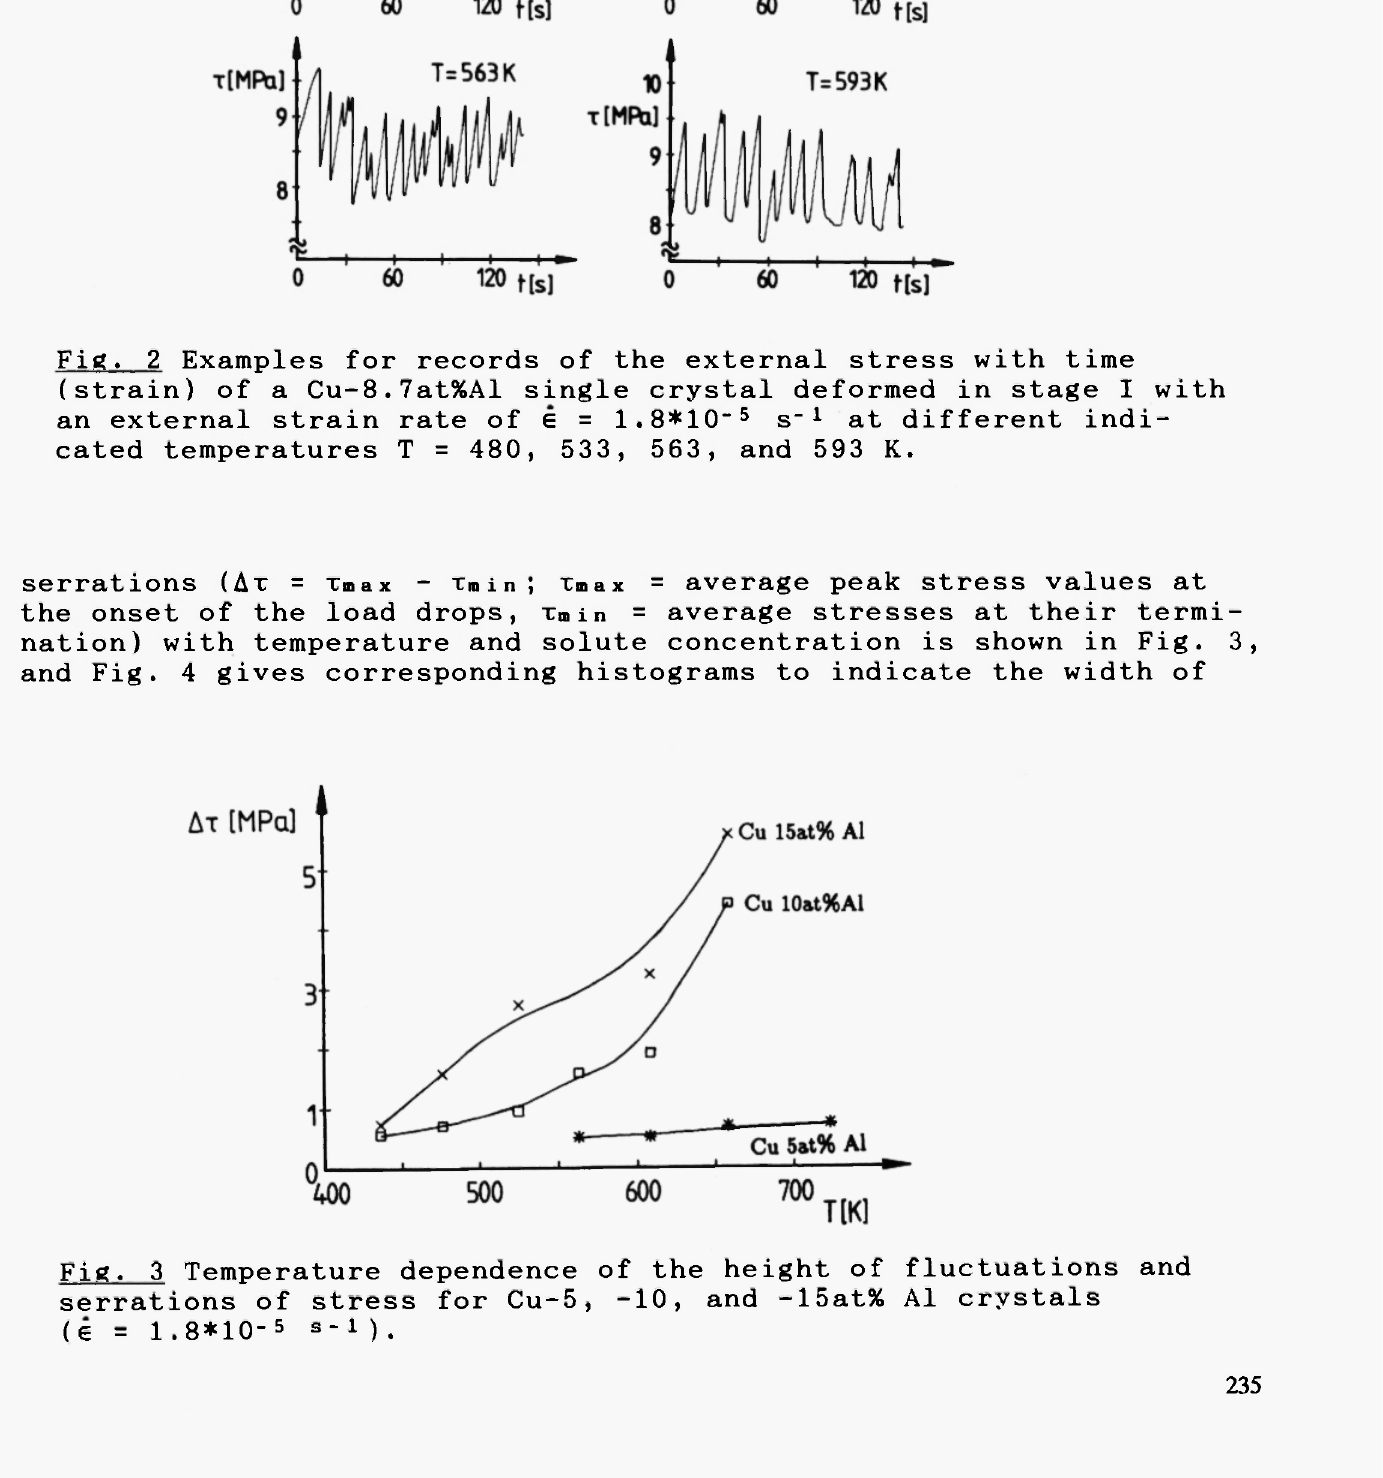
Fig. 2 Examples for records of the external stress with time (strain) of a Cu-8.7at%Al single crystal deformed in stage I with an external strain rate of e = 1.8*10" 5 s" 1 at different indi- cated temperatures Τ = 480, 533, 563, and 593 K.